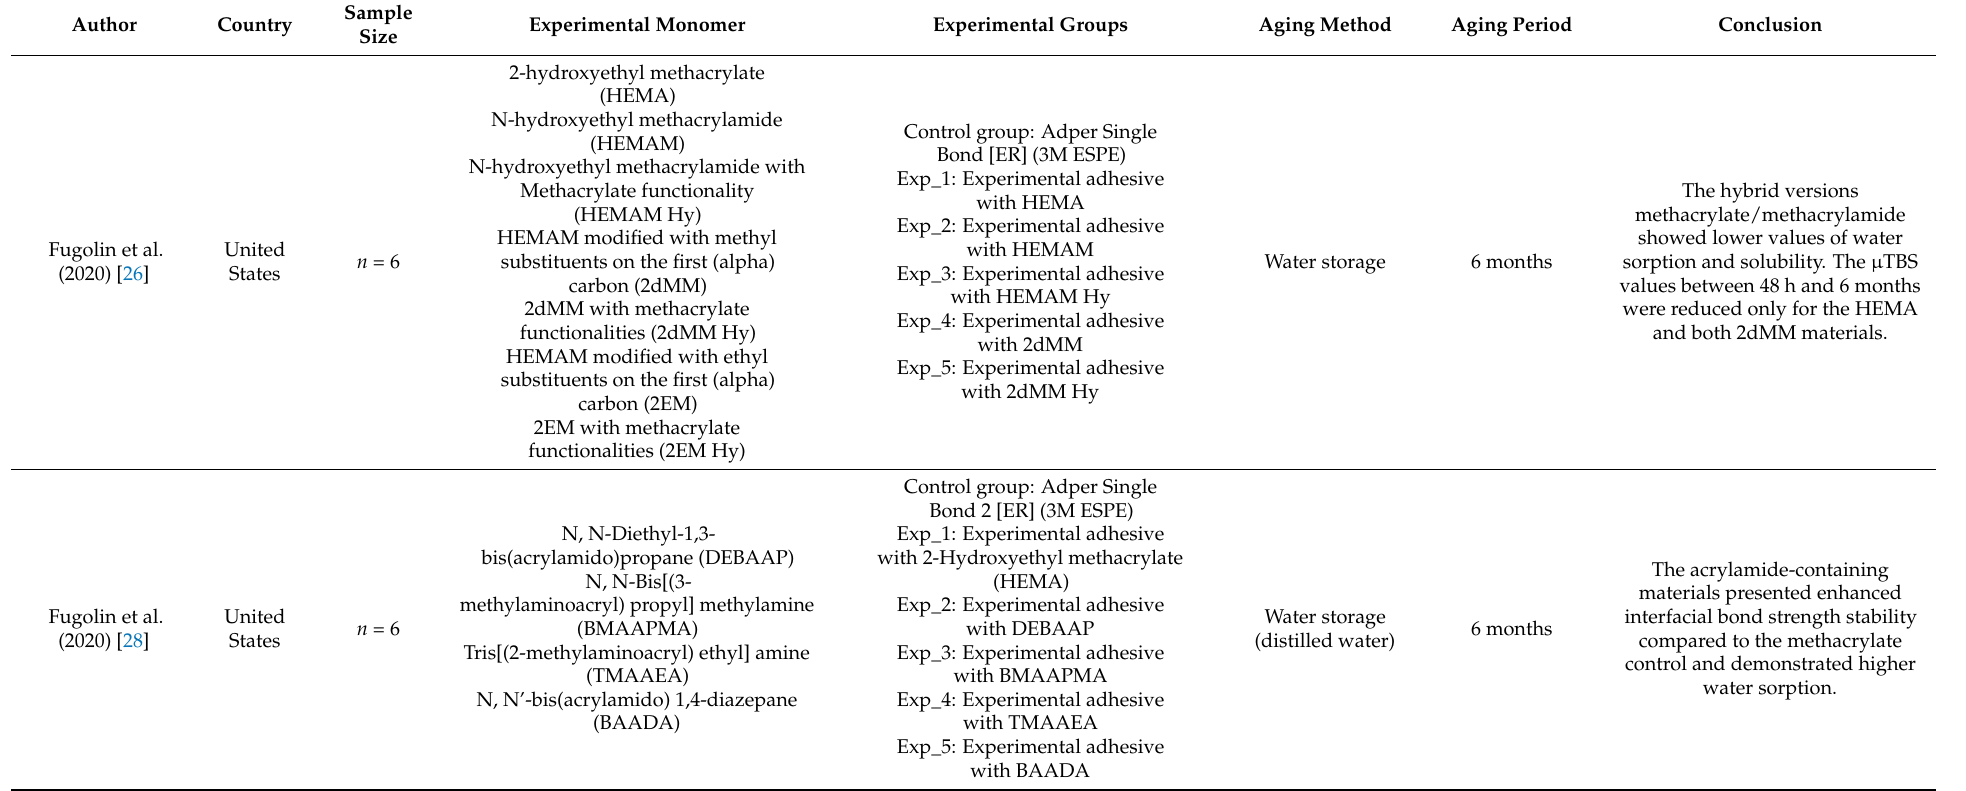
Table 2. Systematic review table summarizing the study characteristics: author/date, country of the study, sample size, experimental monomer, experimental groups, aging method, aging period and final